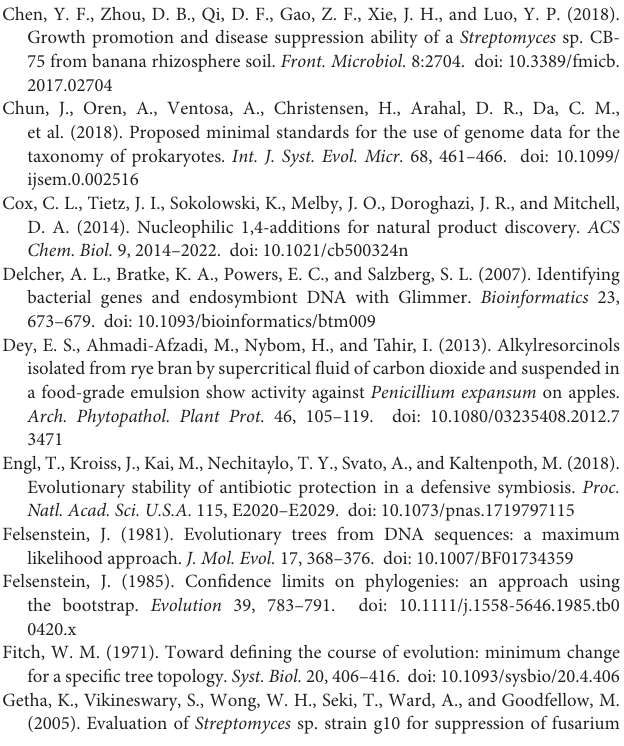
Supplementary Table 1 | Allele sequence accession numbers of the Streptomyces used for the present study. Supplementary Table 2 | MLSA distance values for selected strains in this